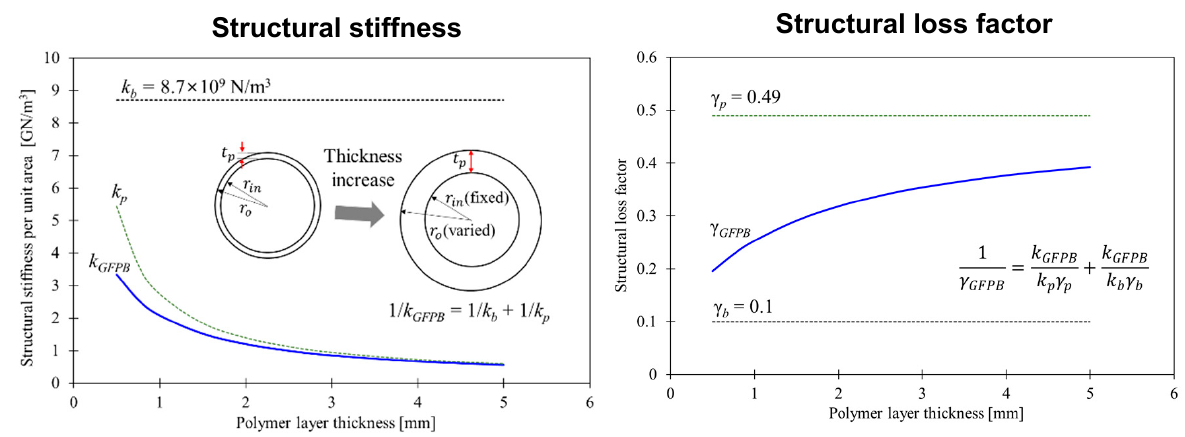
Figure 6. Predicted structural stiffness per unit area and structural loss factor versus the polymer layer thickness. Outer radius of the polymer layer is varied, while the inner radius remains as 20.92 mm.